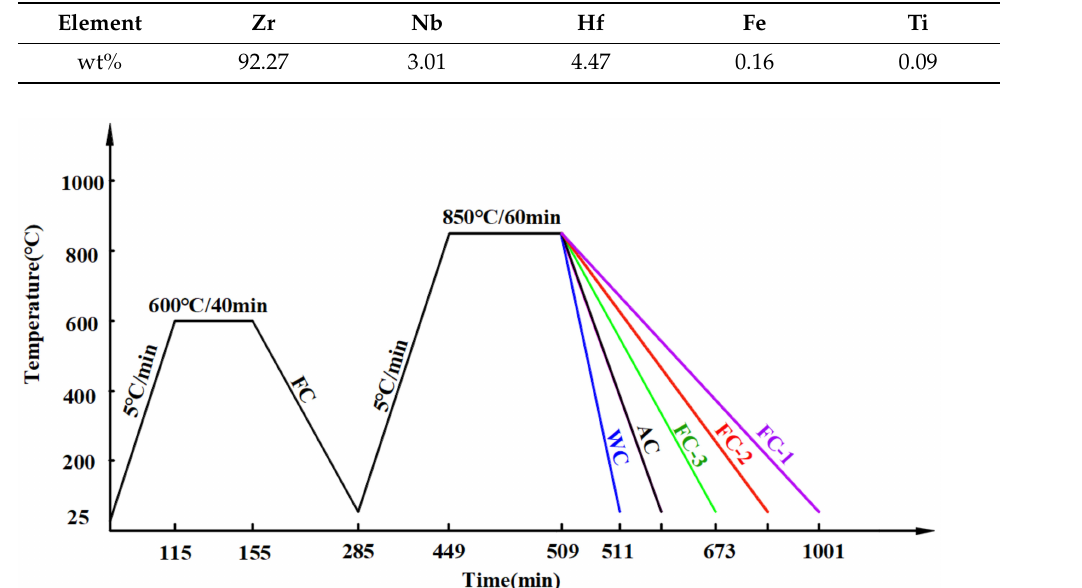
Table 1. Chemical composition of Zr-4Hf-3Nb (wt%) alloy.